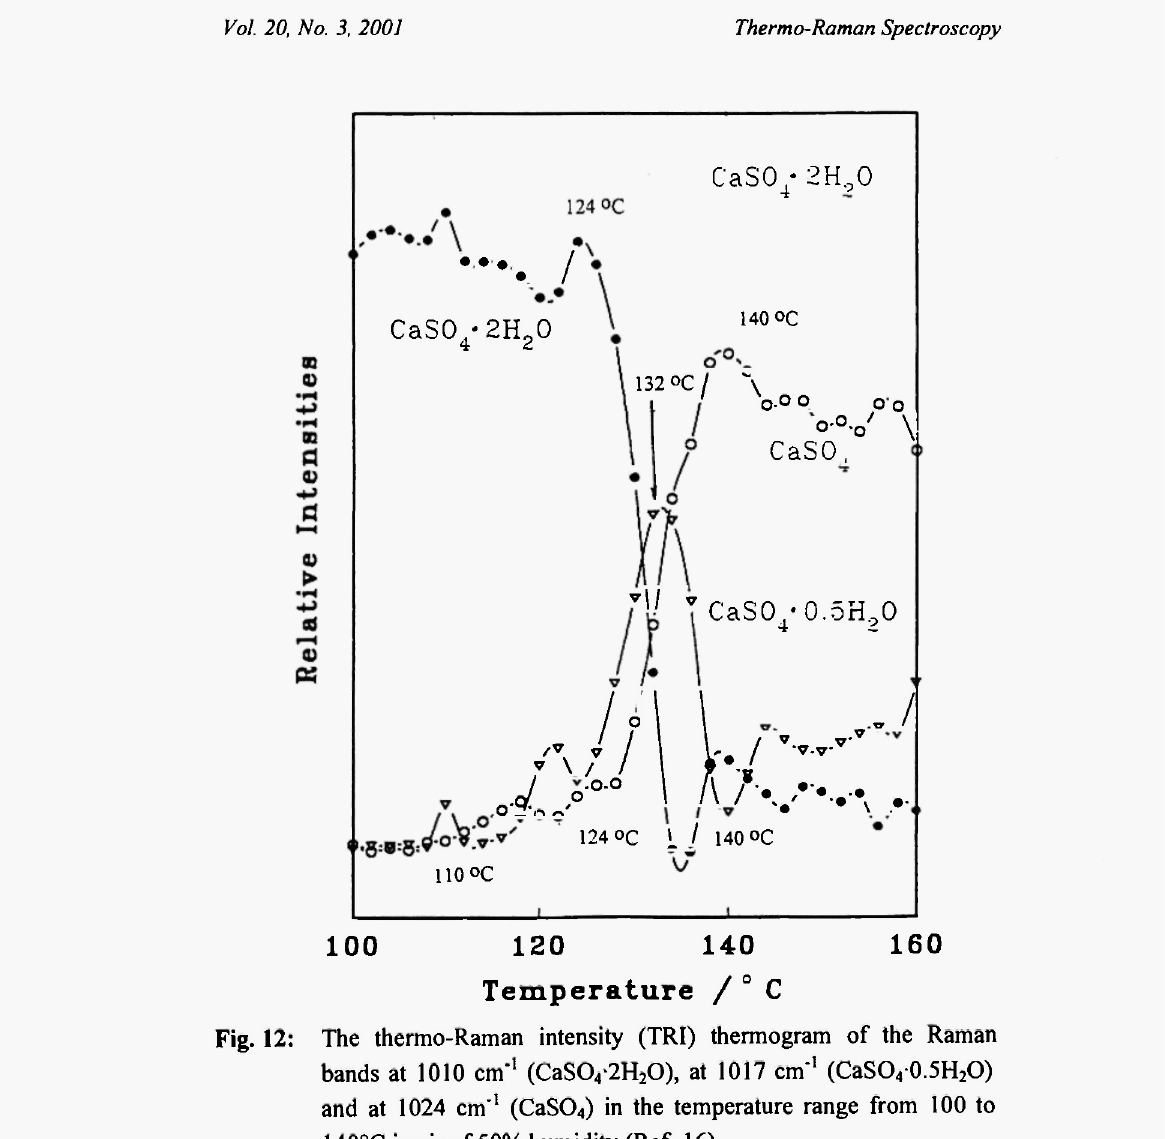
Fig. 12: The thermo-Raman intensity (TRI) thermogram of the Raman bands at 1010 cm" 1 (CaS0 4 -2H 2 0), at 1017 cm· 1 (CaS0 4 0.5H 2 0) and at 1024 cm' 1 (CaS0 4 ) in the temperature range from 100 to 140°C in air of 50% humidity (Ref.